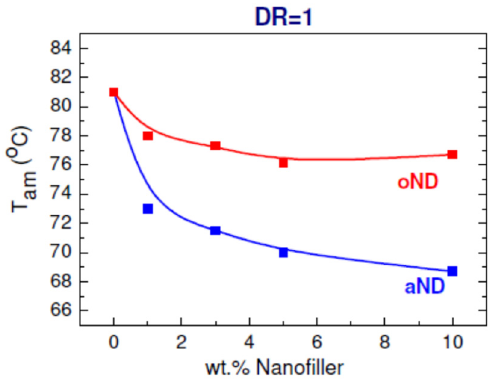
Figure 4. Dependence of the temperature T am on the filler content in the unoriented composite fibers based on HDPE.